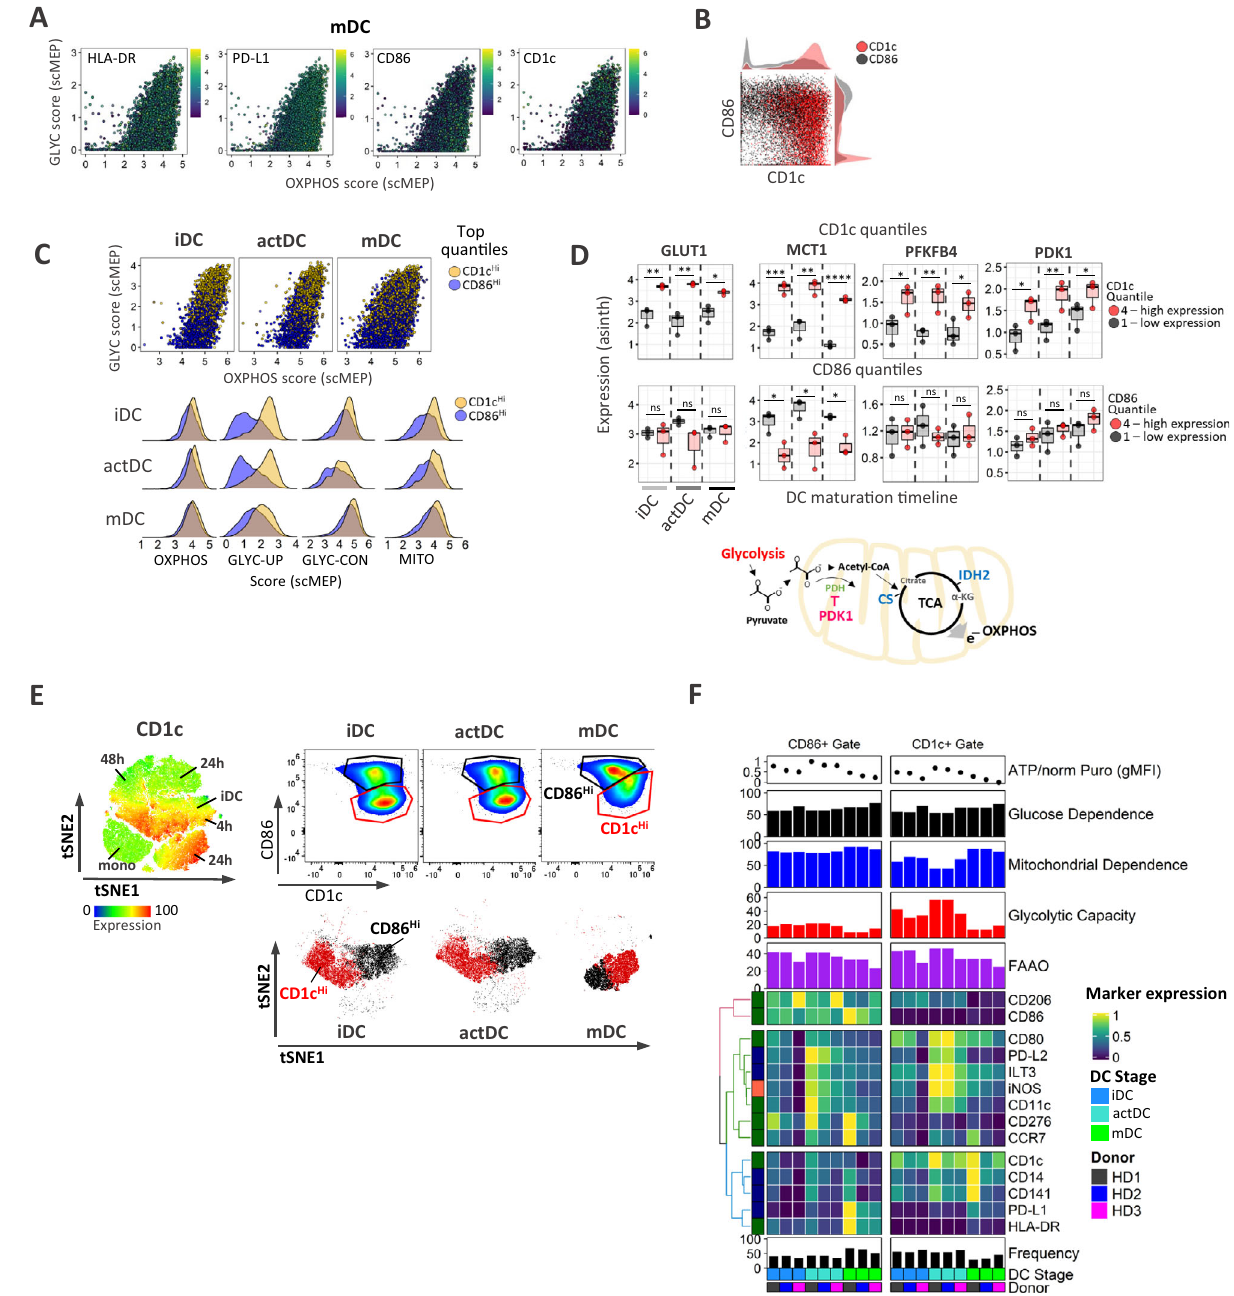
Fig. 3 | Metabolic heterogeneity associates with phenotypic polarization of CD1c hi andCD86 hi DCpopulations.A Correlationanalysisforsingle-cellglycolytic glycolysis and OXHOS scores with heatmap expression single-cell overly of indi- catedimmunemarkers.Subsampledsingle-celldatapointsfortheindividualdonor (out of N =3) are shown for the entire fi gure. B Mass cytometry scatter plots for CD1c and CD86 expression pro fi les were used to emphasize the distribution of CD1c hi and CD86 hi populations. C Shownare single-cellscatterplotcomparisonsof the top 4th quantiles from CD1c hi (blue) and CD86 hi (gold) DC populations. Lower graphs represent histogram distributions of single-cell scMEP metabolic pathway scores in CD1c hi and CD86 hi populations. D Box plots represent median expression values of glycolytic enzymes and PDK1 in the 1st (lowest, black) and 4th (highest, red)quantilefromCD1candCD86populationsacrossiDC,actDC,andmDCfrom3 independent donors. Statistical signi fi cance was calculated using